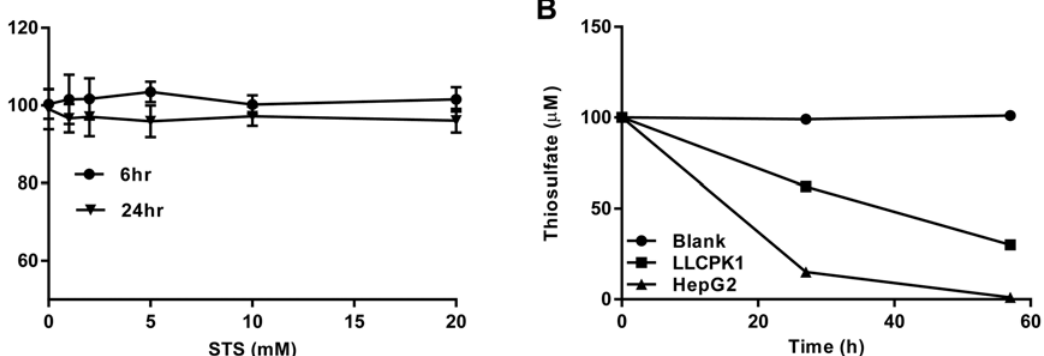
Fig 6. STS is non-toxic and can be incorporated by the LLC-PK1 cells. (A) In vitro toxicity studies with LLC-PK1 cells showed no significant changes in cell viability even at 20 mM STS for a period of 24 hrs in serum and pyruvate free DMEM media. (B) STS is decreasing in the supernatant of LLC-PK1 cells as detected by HPLC (HepG2 used as positive control and blank wells as negative